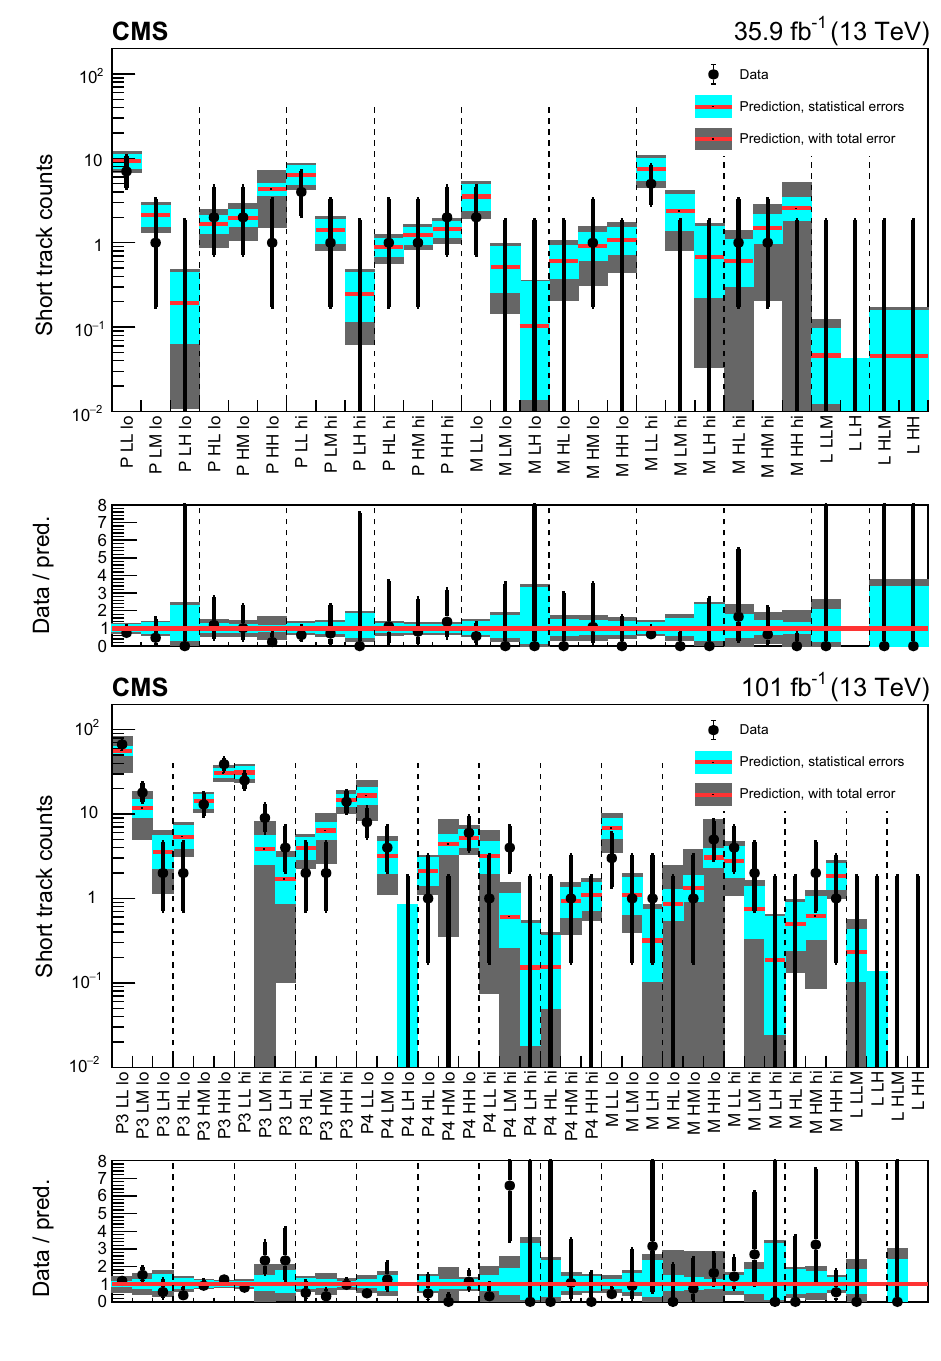
Data Prediction, statistical errors Prediction, with total error